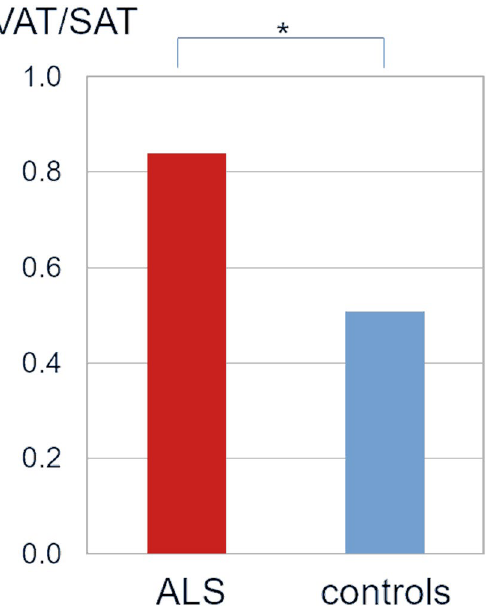
Figure 5. Ratio of visceral adipose tissue (VAT) and subcutaneous adipose tissue (SAT) for 34 ALS patients vs. 34 controls (test sample data). Error bars are the standard error of the mean; * p < 0.01.